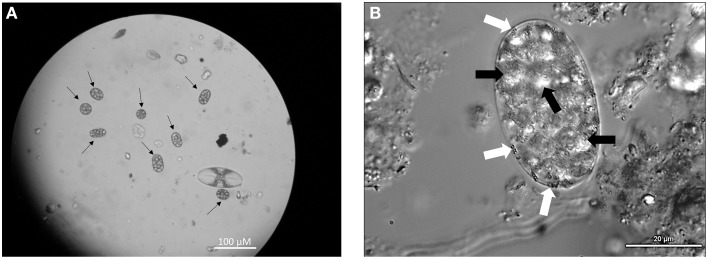
(A) Light microscopy image of Achromatium (black arrows), highlighting their range of sizes and shapes at Warm Mineral Springs. (B) Phase contrast microscopy of Achromatium. Calcite inclusions (black arrows) can be seen throughout the cell, while small sulfur inclusions (white arrows) can be seen at the periphery.